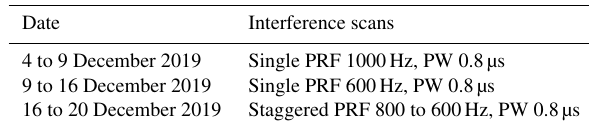
Table 3. Transmit test configurations from 6–20 December 2019. Operational radars pointing towards radar